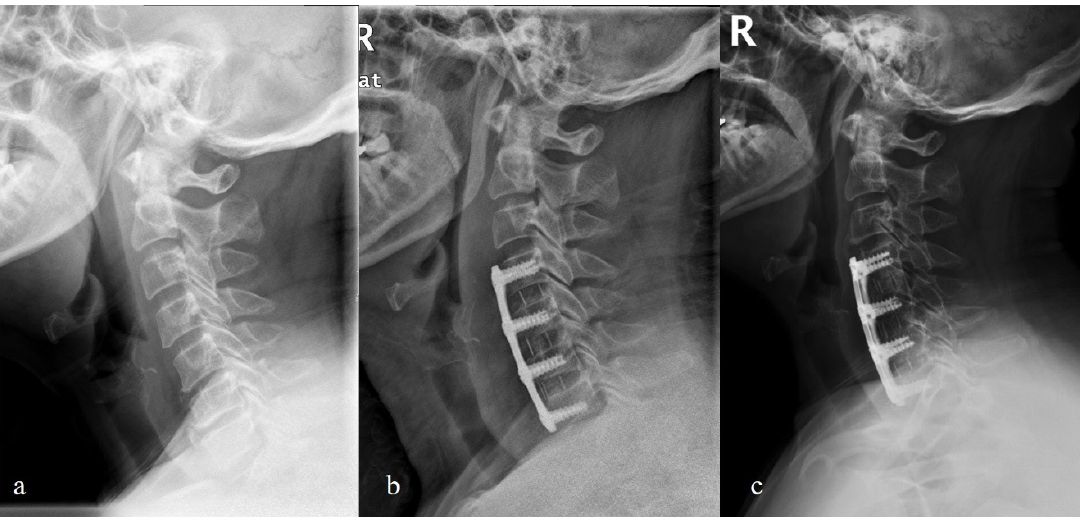
Figure 4. Lateral radiographs of one patient receiving anterior plate and cage system. ( a ) Preoperative C2-C7 Cobb angle was 10 degrees; ( b ) postoperative C2-C7 Cobb angle increased to 22 degrees; ( c ) the C2-C7 Cobb angle maintained 18 degrees at the 3-year follow-up.